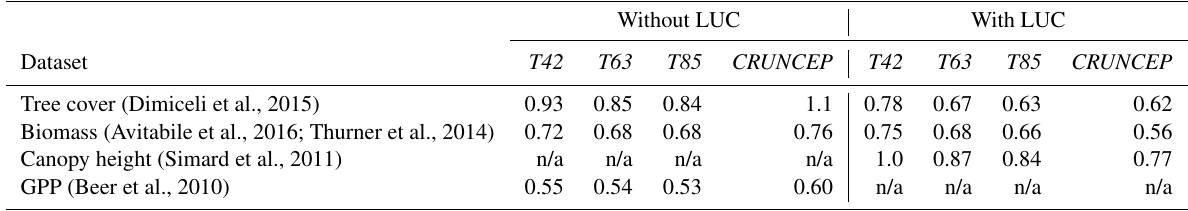
Table 1. NME scores for the vegetation produced by the T42 , T63 , T85 , and CRUNCEP simulations compared to four gridded global datasets both with and without a LUC (land use correction) where applicable. Note that lower scores imply better agreement between simulation and observation. n/a: not